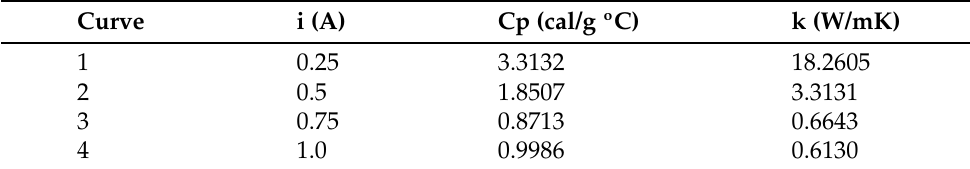
Table 1. Specific heat capacity and thermal conductivity estimation in